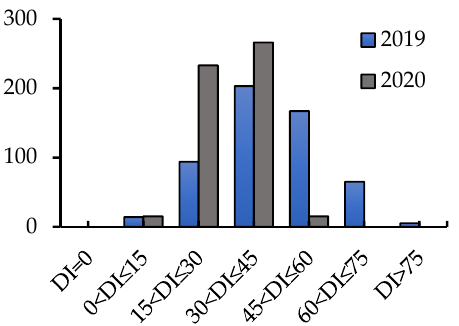
Table 1. ANOVA for wheat reactions to CR in 2019–2021.